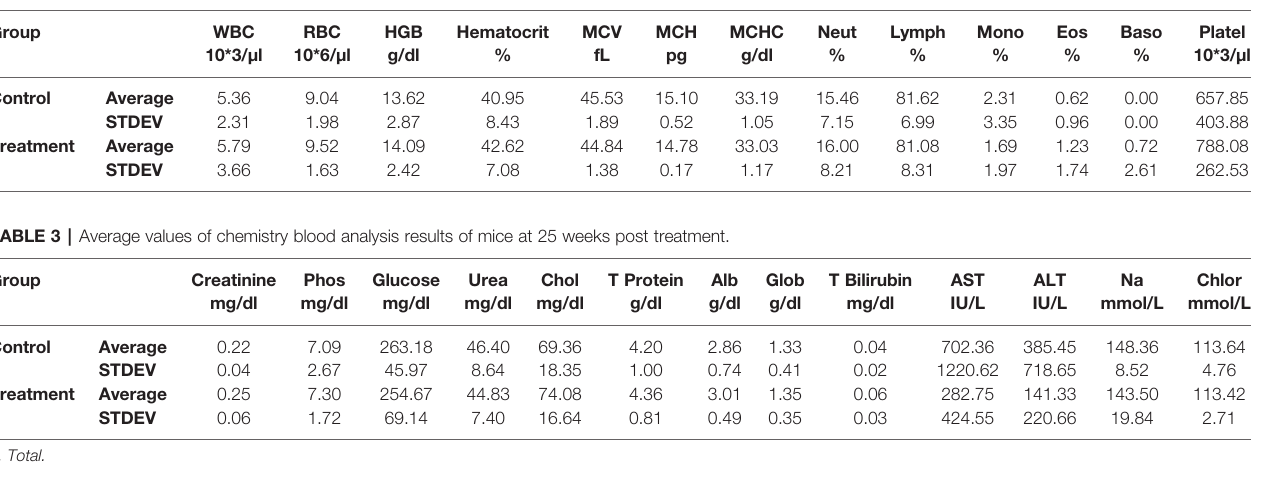
TABLE 2 | Average values of hematology blood analysis results of mice at 25 weeks post treatment. Group